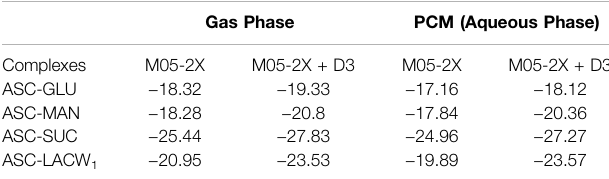
TABLE 3 | The binding energies (kcal/mol) of ASC eutectics in gas phase and water